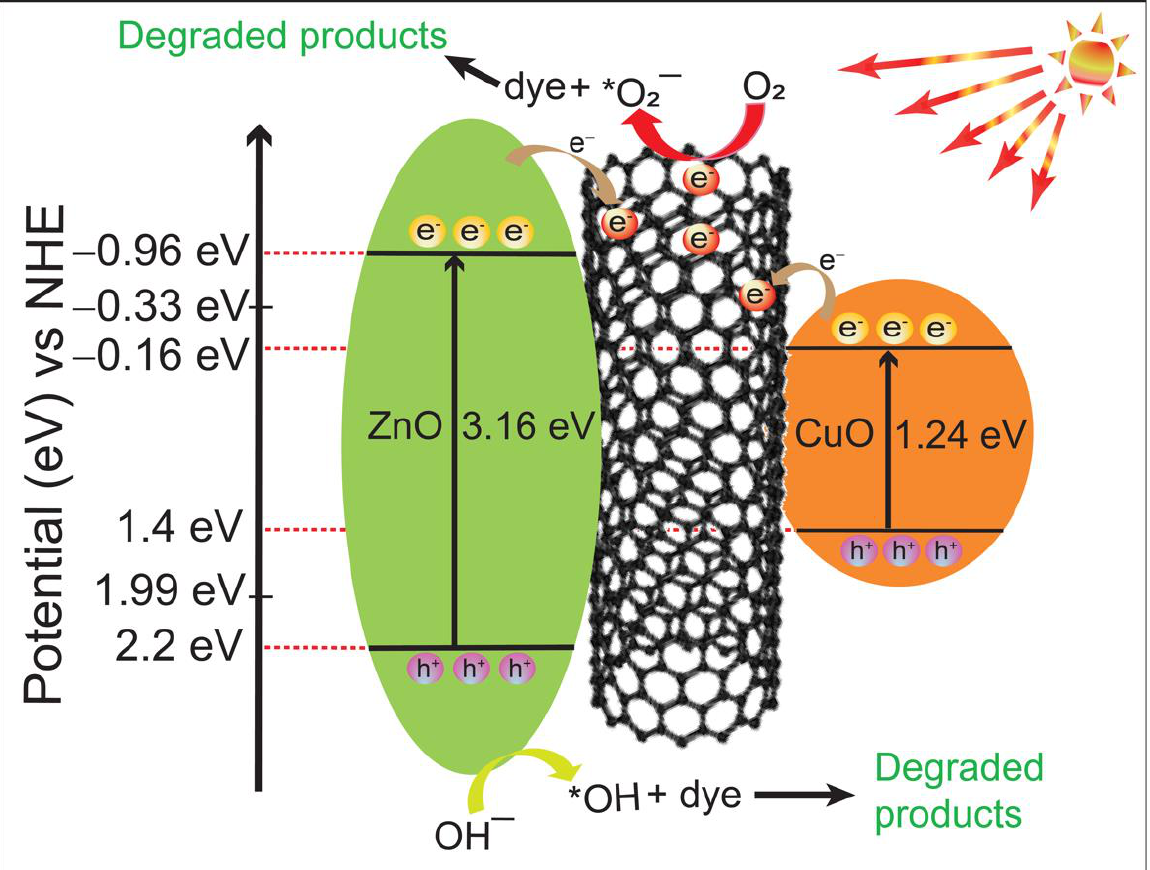
Figure 11. The bandgap structure and scheme for photoexcitation of e–h pairs, revealing the catalytic action of the ZSC3 heteronanocomposite.